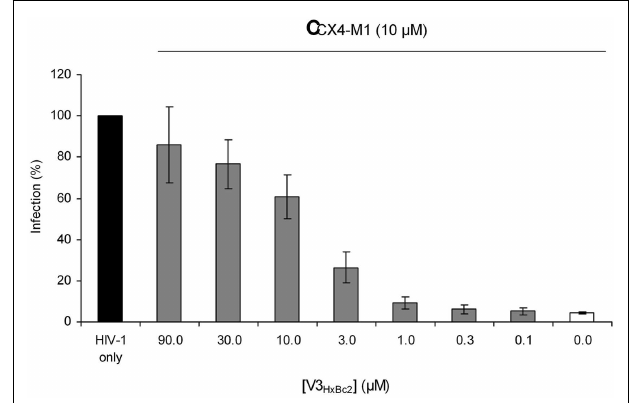
FIGURE 10 | Dose-dependent effect of theV3 loop peptideV3 HxBc2 on the CX4-M1 – induced inhibition of infection of CEMx174 cells with HIV-1 NL4-3 . See Section “Materials and Methods” (reporter cell assay) for experimental detail. Error bars present standard errors of the mean